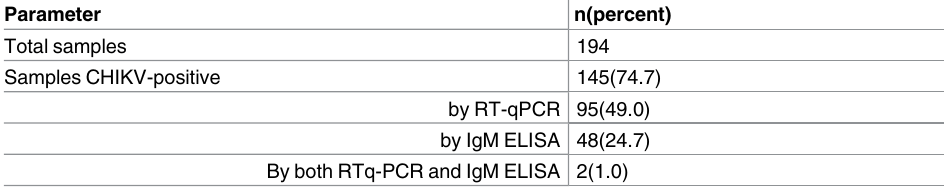
Table 1. Diagnostic outcomes for serum samples collected from patients in La Romana, Dominican Republic between July 2014 and August 2014